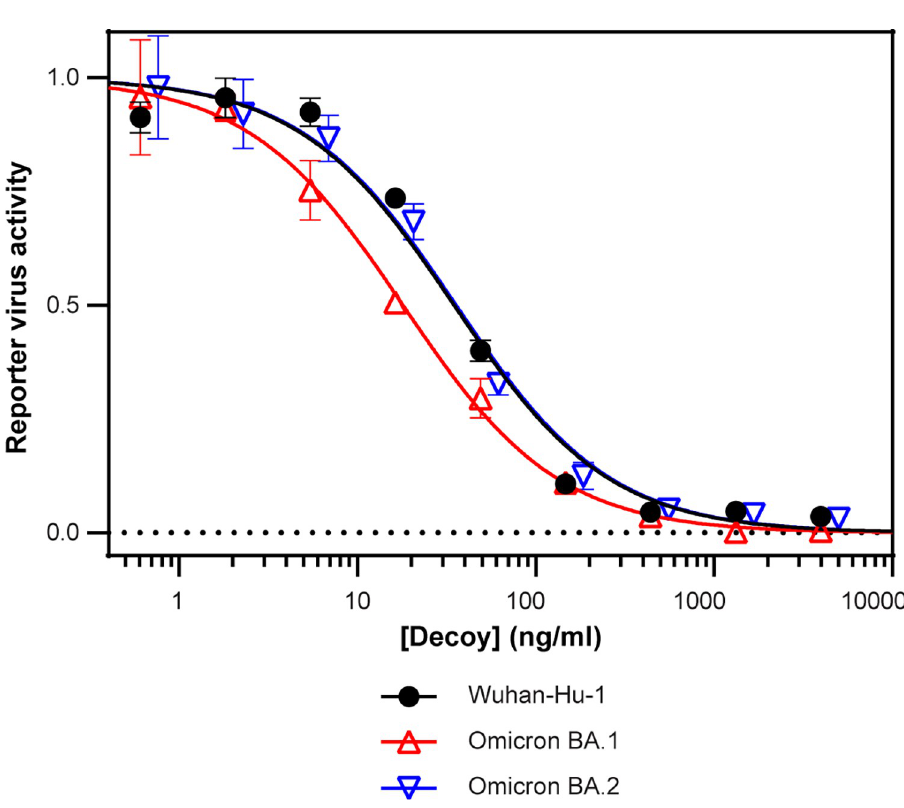
Fig 2. CDY14HL maintains potent neutralization for diverse SARS-CoV-2 variants. Viral neutralization assay using lentiviruses pseudotyped with the ancestral (Wuhan-Hu-1), Omicron BA.1, or Omicron BA.2 variant spike protein. Error bars represent standard deviation of at least three replicate